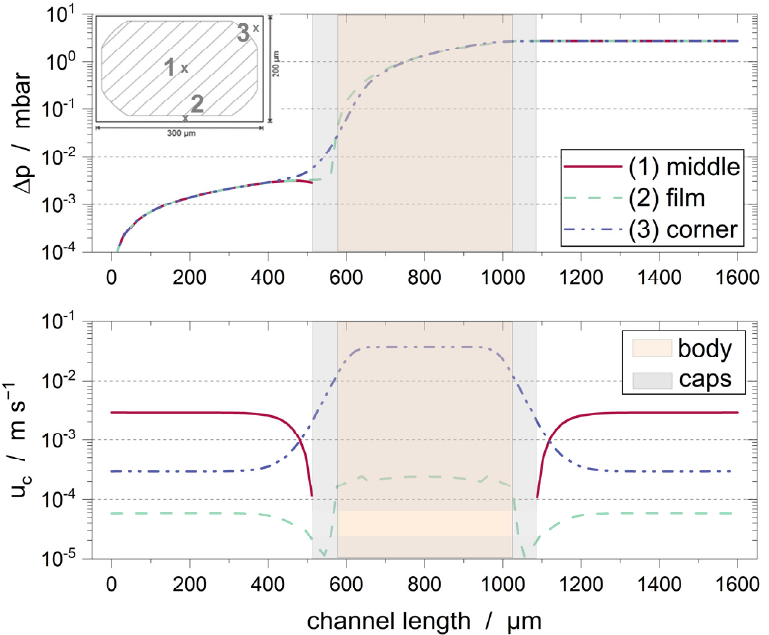
Figure 10. Differential pressure drop Δ𝑝 ( top ) and the velocity of the continuous phase u c ( bottom ) along different lines (top left corner) in the microfluidic channel at ϑ exp = 20 ◦ C and u c = 1.4 · 10 − 3 m s − 1 . The orange region represents the body of the particle ( l body = 580 µ m) and the grey regions of the two caps ( l cap = 45 µ m). Please notice the different scales (logarithmic and linear) of the axis of ordinates.